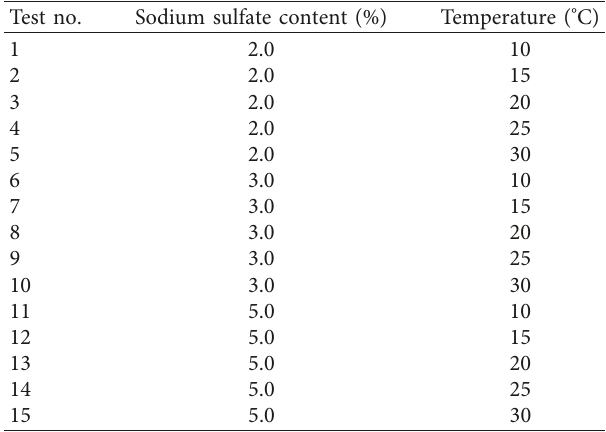
Table 2: Test parameters for salt expansion of sulfate saline soil under temperature and RH. Test